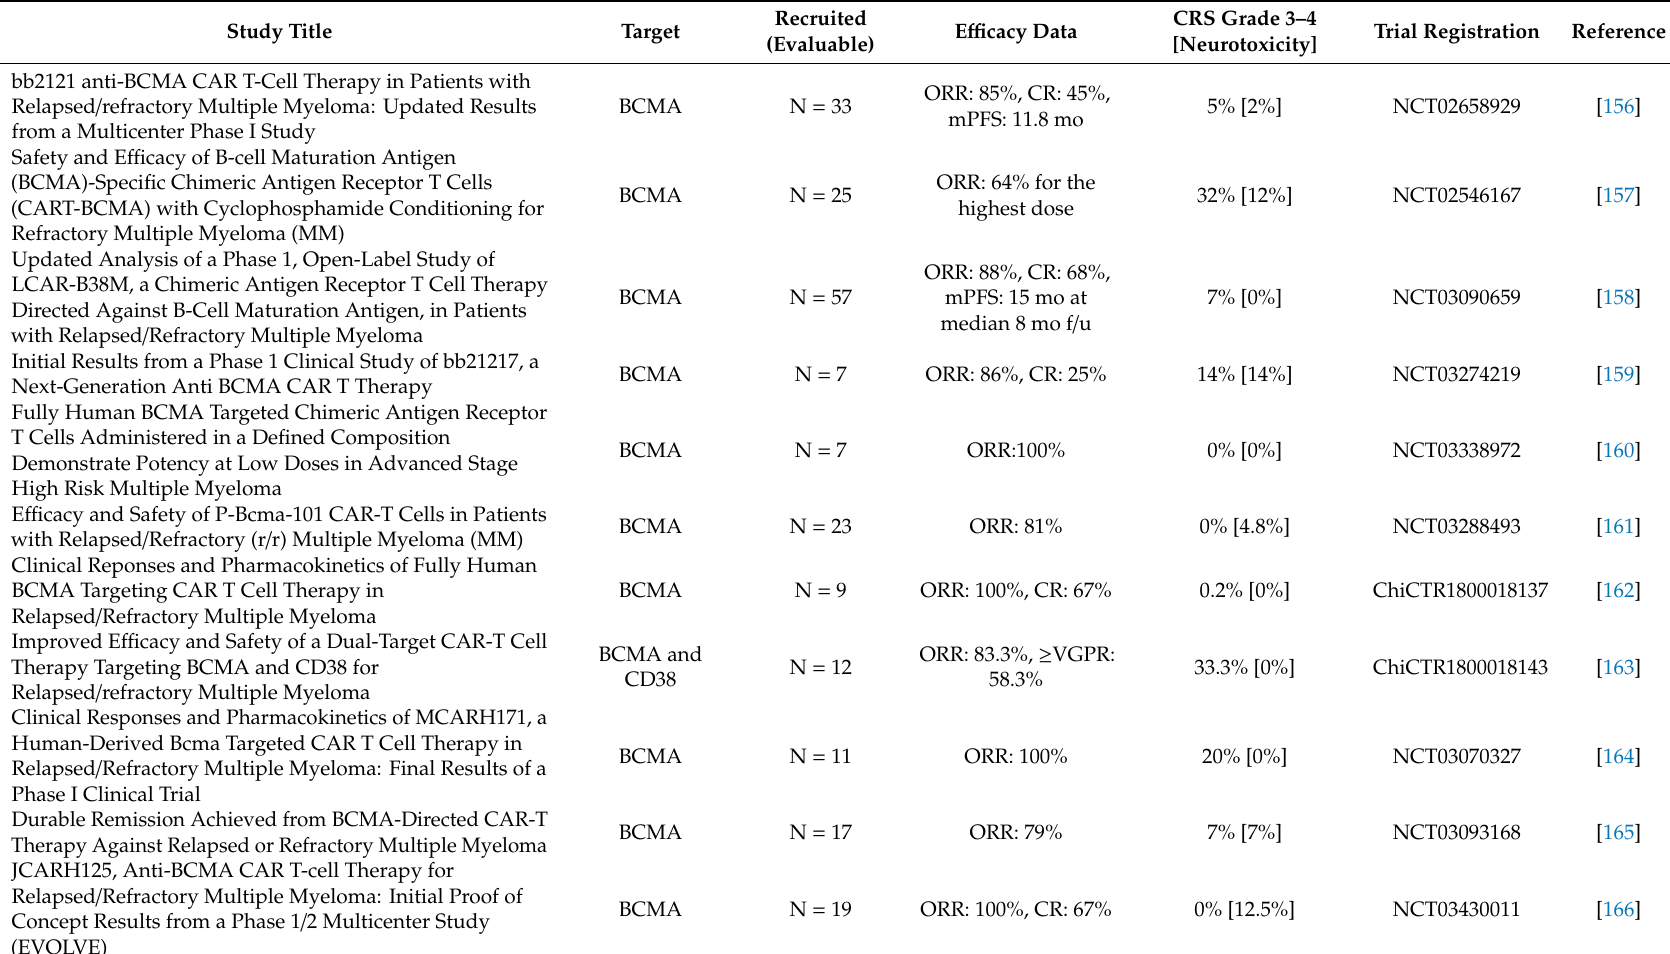
Table 2. CAR-T cell therapies, ADC, and